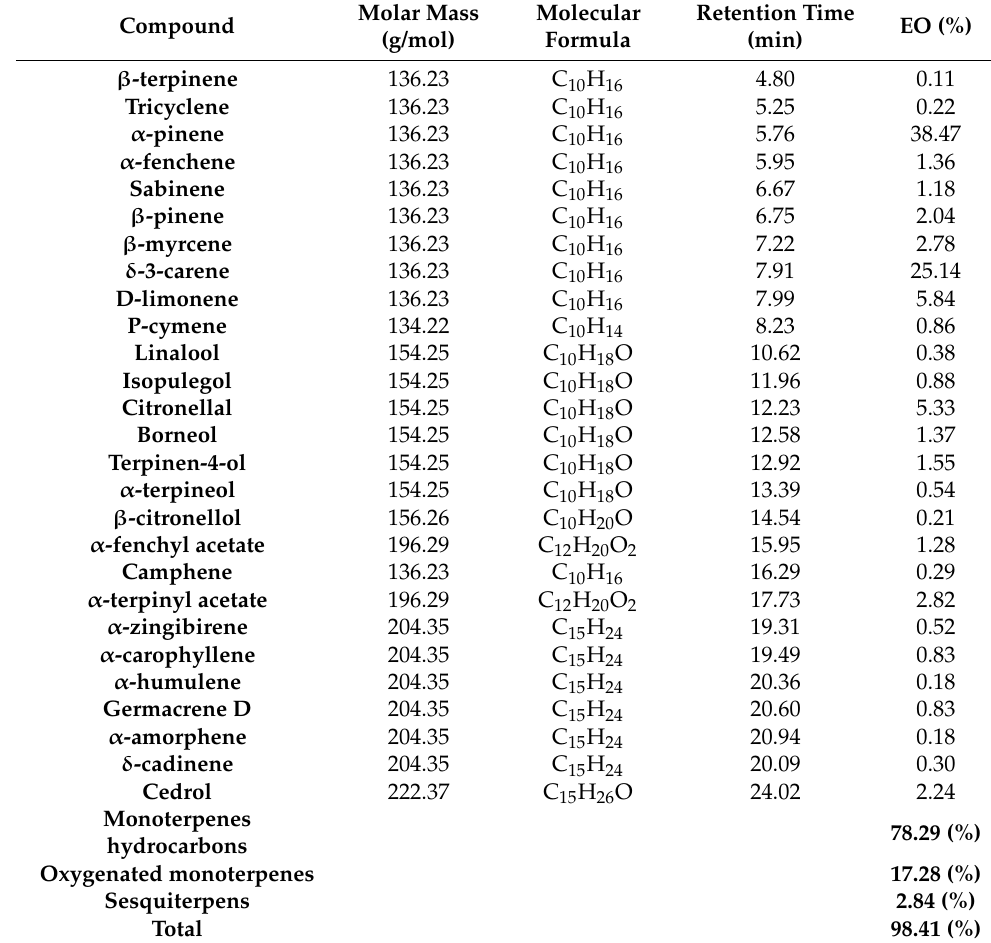
Table 1. Chemical composition of (CSEO).